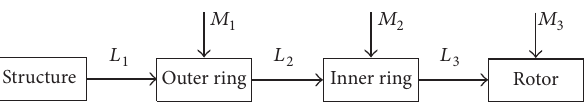
Figure 2: Composition diagram of multiple cardan